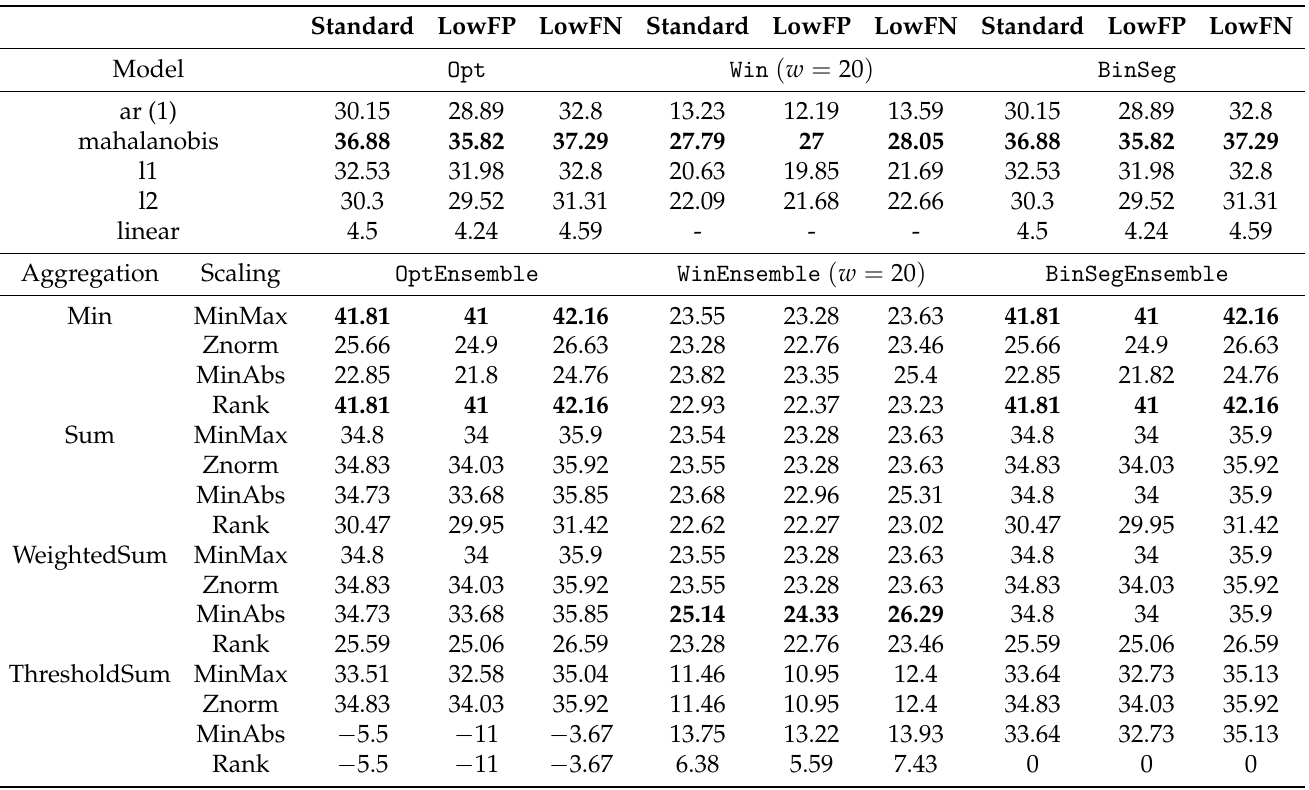
Table 2. NAB scoring algorithm (higher is better) results of the CPD algorithms on the TEP